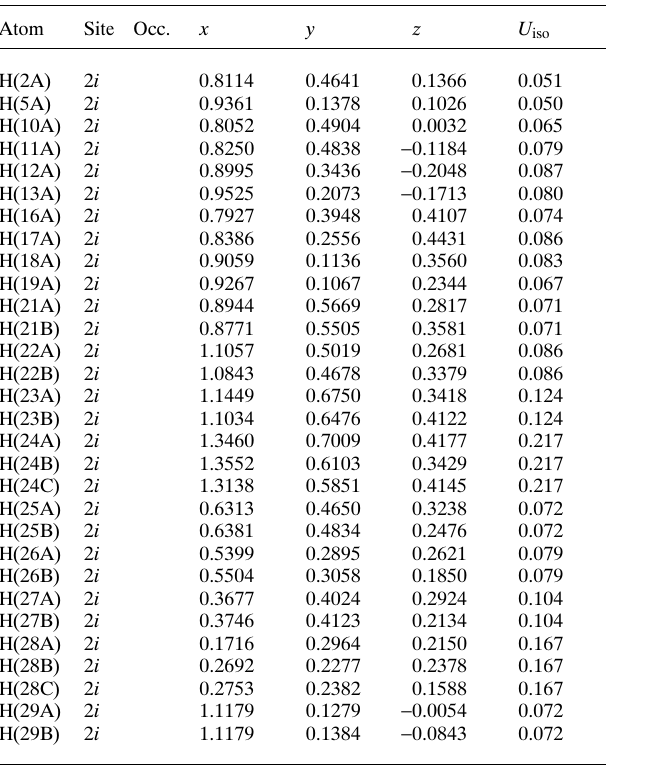
Table 2. Atomic coordinates and displacement parameters (in Å 2 ) .